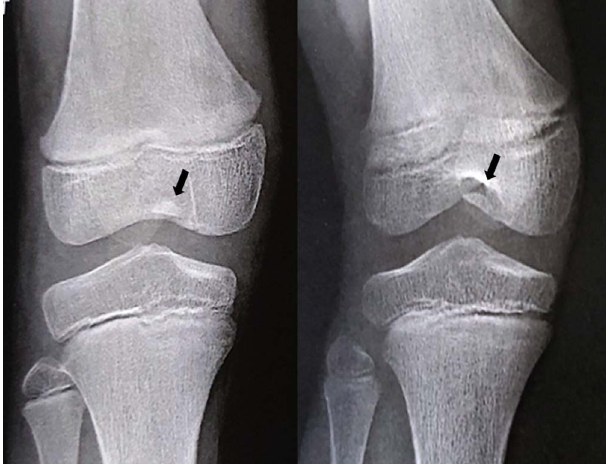
Figure 3. Arthroscopic view of the PCL ’ s cartilaginous femoral defect after debridement. MFC = Medial Femoral Condyle.